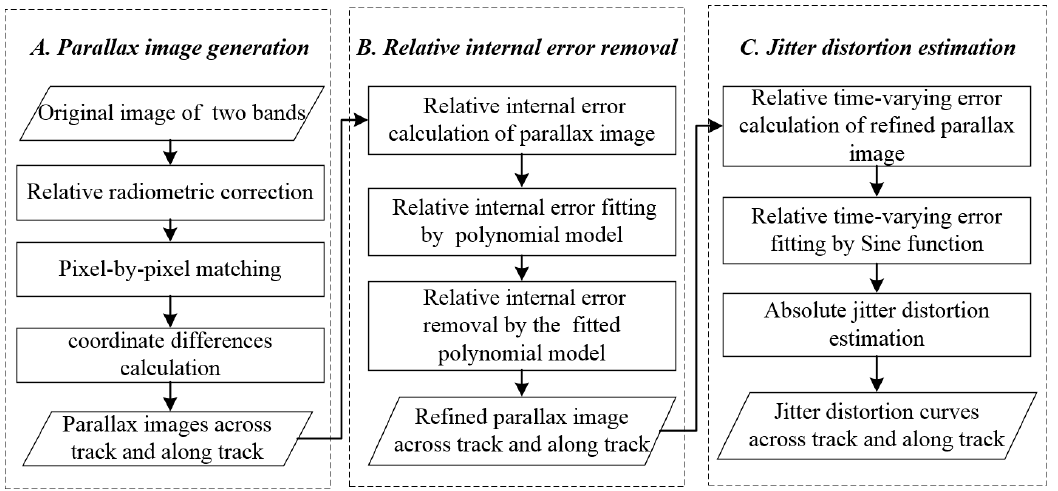
Figure 2. Workflow of jitter detection of Gaofen-1 02/03/04 satellites using multispectral imagery.